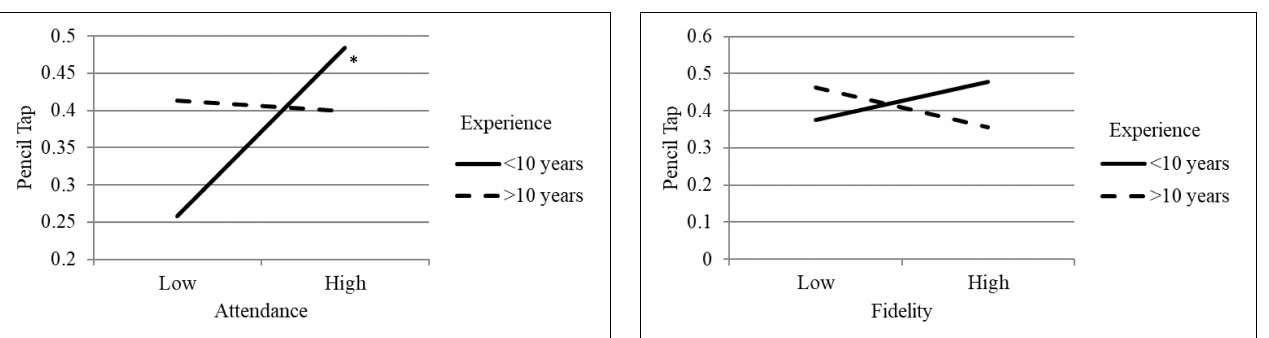
( M = 1.69 and 1.44, respectively). Nevertheless, the finding